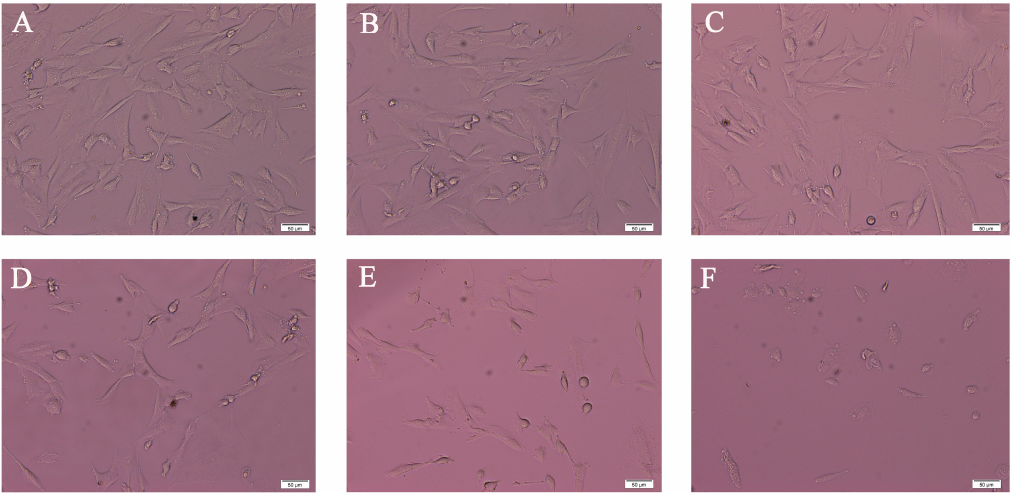
Figure 1. Effects of PFOS on SK-N-SH cell morphology. SK-N-SH cell morphology was observed after a 48-h exposure to various concentrations of PFOS. ( A ) Control; ( B ) 50 μ M PFOS; ( C ) 100 μ M PFOS; ( D ) 150 μ M PFOS; ( E ) 200 μ M PFOS; ( F ) 250 μ M PFOS. (Bar: 50 μ m).